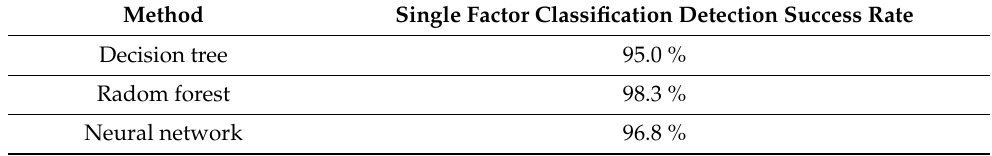
Table 12. Comparison of single factor classification